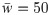
Effect of initiative on the coevolution of society.From top to bottom, average power, Gini index and average frustration at different values of initiative K evolving in time (Monte Carlo steps), starting from an equilibrated random graph with N = 1000 nodes and p = 0.1 attachment probability (thus average wealth w¯=50, constant during the evolution), at minimal disorder T = 0.1. The A, B and C insets represent the average wealth (red, values on the right axis) and degree distributions (blue, values on the left axis) for KT = 1.6 at times 1.5 ⋅ 108 (three social classes), 2.5 ⋅ 108 (two classes) and 2.6 ⋅ 108 (one class).